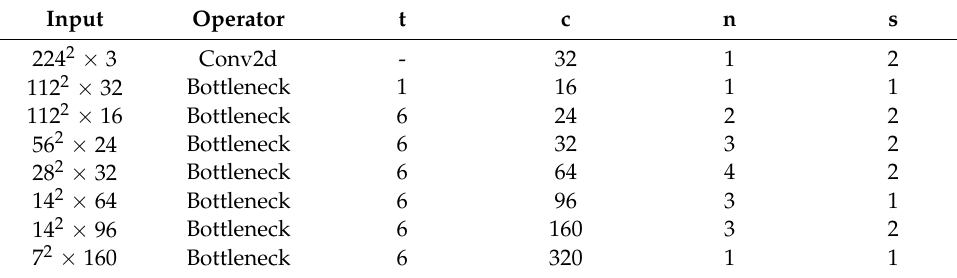
Table 2. MobileNetV2+ SENet network structure.